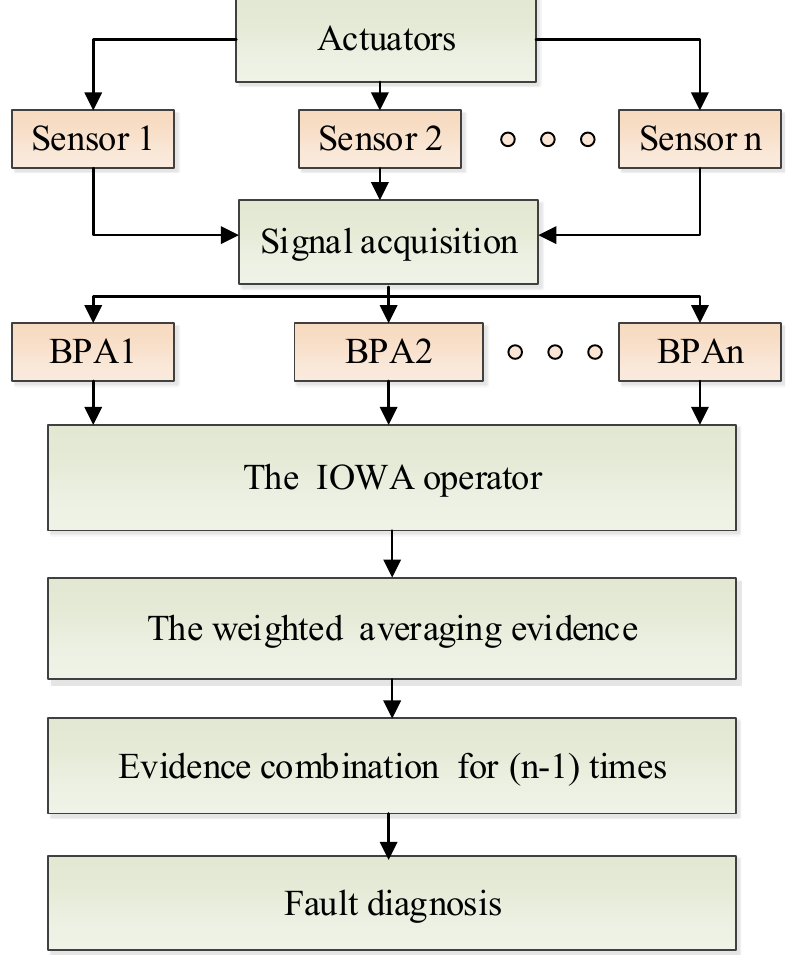
Figure 2. Overall structure of fault diagnosis based on sensor data